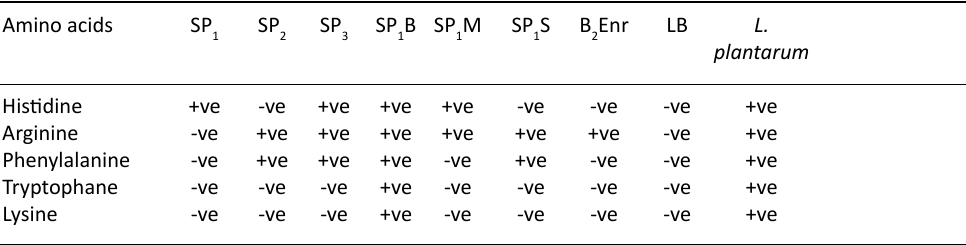
Table 4. Biogenic amines (BA) production by probiotic isolates Amino acids